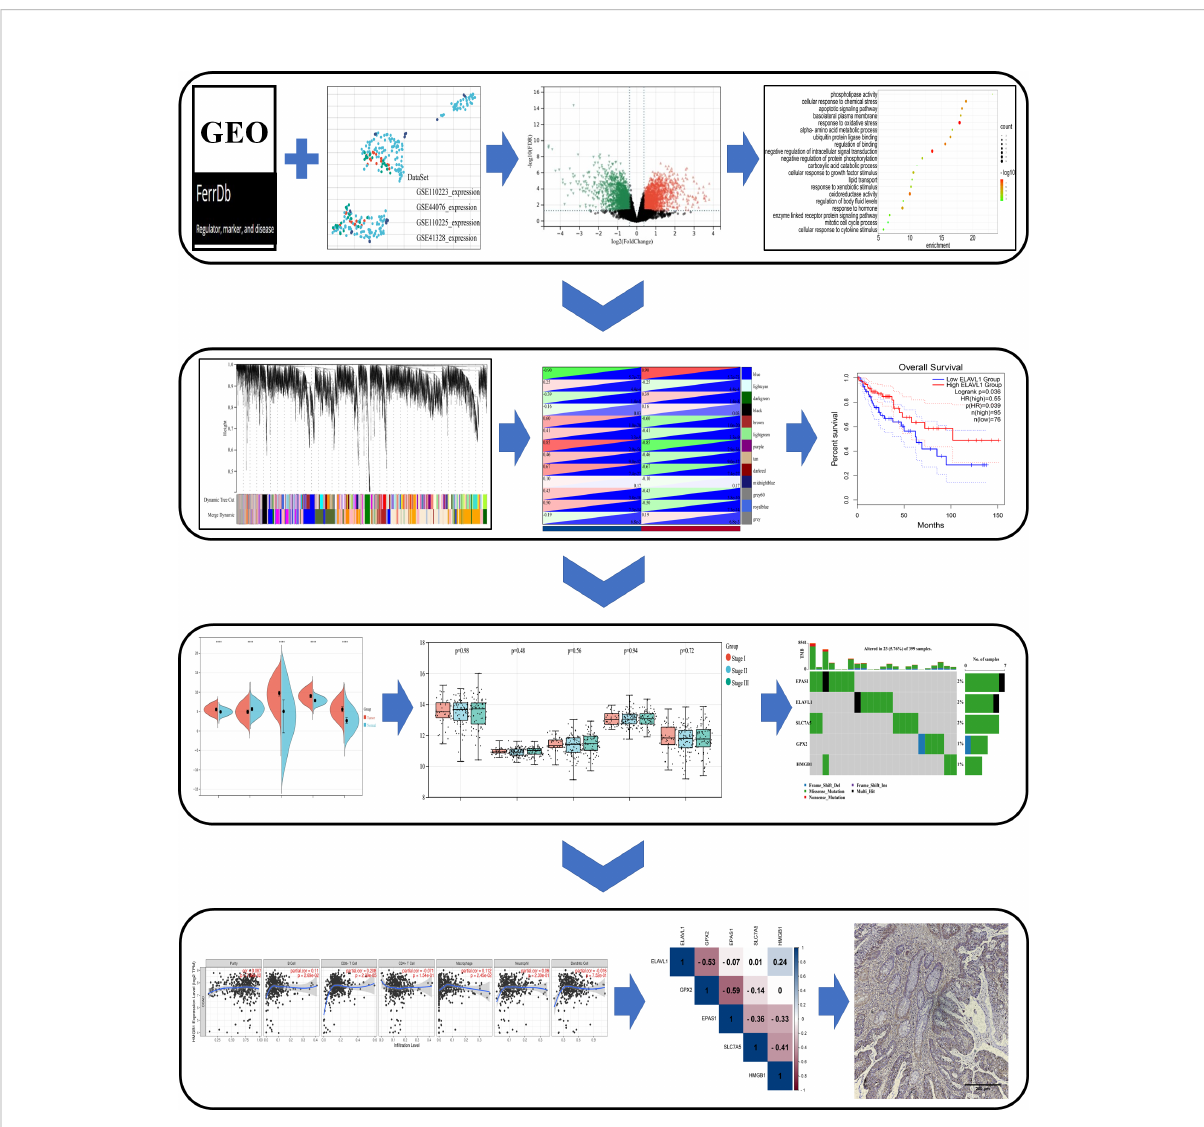
FIGURE 1 Schematic diagram of the study design. Differentially expressed genes (DEGs) associated with ferroptosis were identi fi ed in the GEO dataset and FerrDb database. Based on these DEGs, a study was conducted in the Metascape, WebGestalt database for enrichment analysis, and WGCNA and PPI analysis, and were analyzed by Cox survival analysis to obtain the key genes. The core genes were evaluated in multiple databases for gene characterization, downstream functional enrichment, mutational analysis and immune cell in fi ltration associated with ferroptosis. Validation of core gene expression by clinical samples from colon cancer